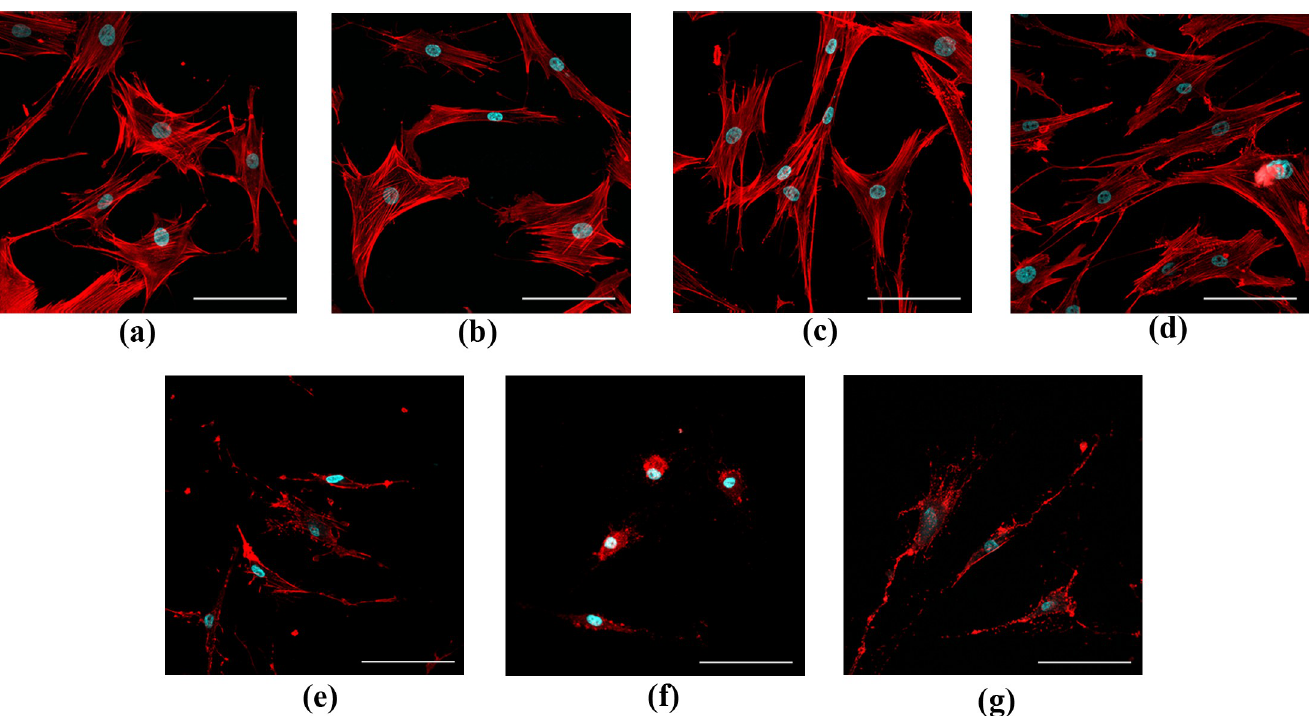
Fig 3. Representative images of F-actin staining (red channel) in FRSN cells in control and after 30 min incubation with Lat B. (a) Untreated cells and (b) cells treated with 10 μ M DMSO (vehicle). (c-g). Cells treated with 10, 50, 500, 1000 and 10000 nM Lat B, respectively. Cell nuclei were counterstained with Hoechst (blue channel). Scale bar is 100 μ m.